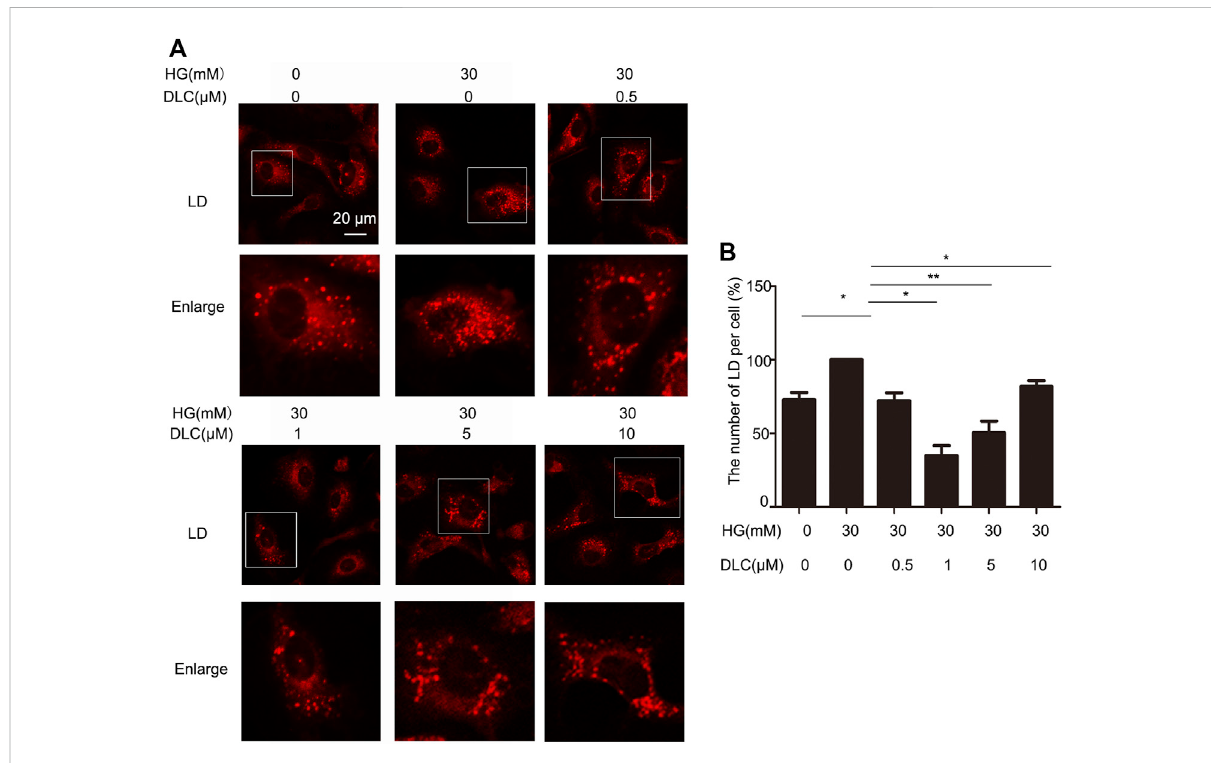
FIGURE 3 DLC suppressed lipid droplet number in HUVECs. (A,B) HUVECs were treated with DLC (0,0.5,1,5,10 μ M) for 24 h under HG (30 mM) condition and stained with neutral lipid stain. The number of LDs was counted by ImageJ. Scale bar, 20 μ m * p < 0.05, ** p < 0.01, n =